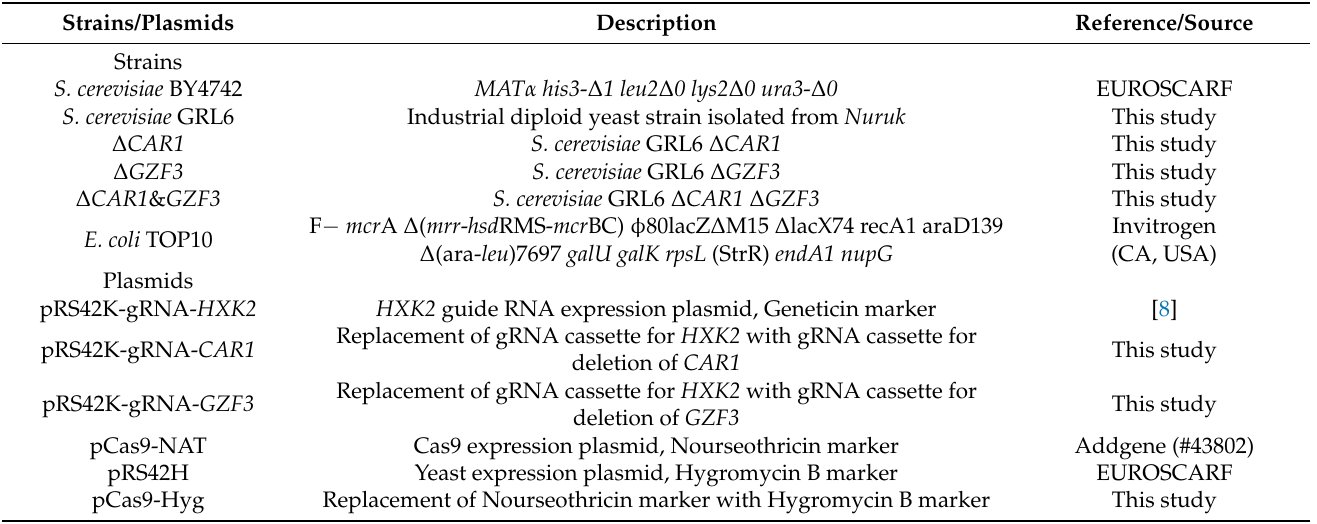
Table 1. Strains and plasmids used in this